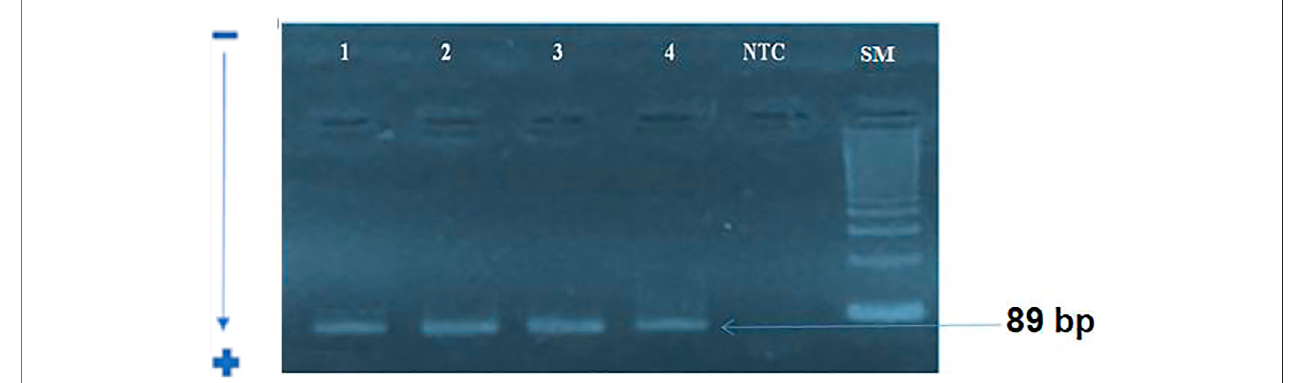
FIGURE3| electrophoreticpro fi leofUL138geneampli fi cationbynested-PCR:Asinglebandcorrespondingtotheexpectedsizeof89 bpforstage2.SM:100 bp size marker, NTC: Negative control; 1: positive sample; 2 – 4: studied samples.